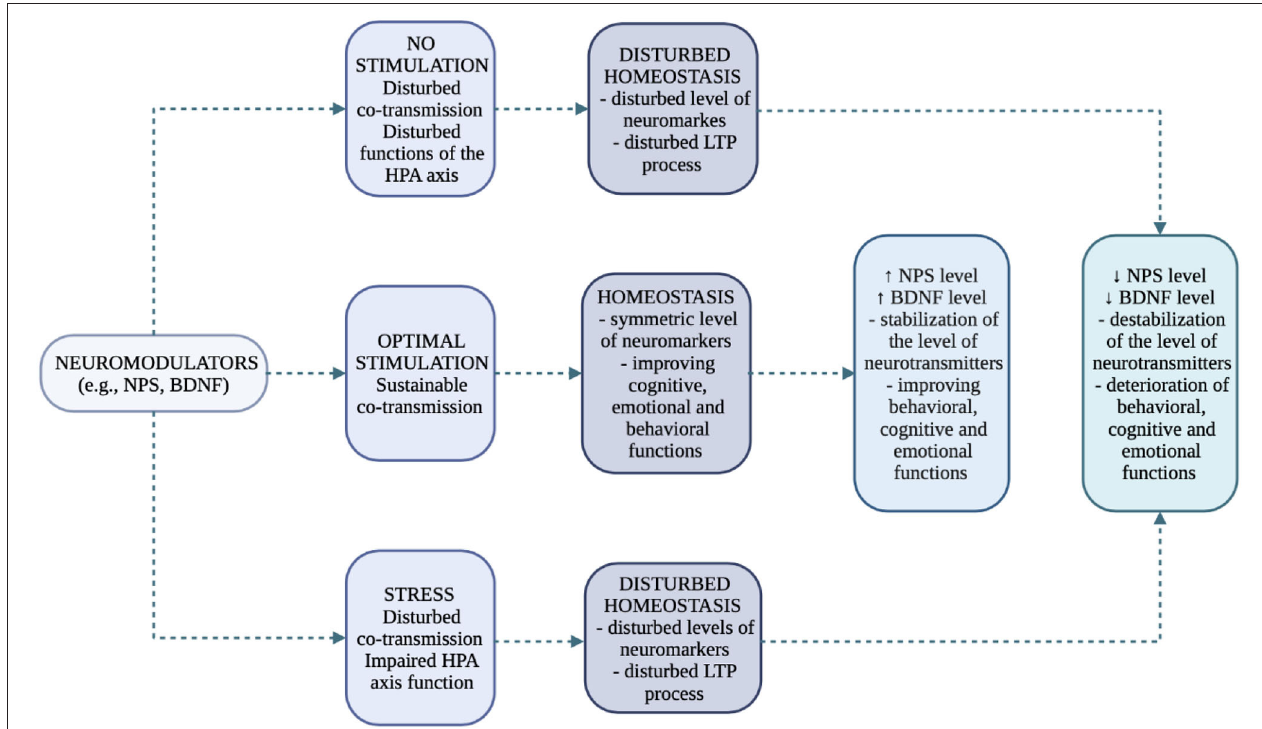
FIGURE 4 | Functions of neuromarkers and their effects in the process of neurogenesis (own work based on the literature) (19, 39, 41–44). The limbic system (cerebral cortex, subcortical structures including the amygdala nuclei, hippocampal bend) is involved in the process of perception of a stressful situation (externally and internally conditioned). A stressful situation has a two-stage course and is subject to primary verification by the amygdala and secondary verification by the hippocampus. The amygdala transmits single sensory signals (autonomic and endocrine responses), while the hippocampus transmits the processed and analyzed signals that are directed from the thalamus and areas of the cerebral cortex. The goal of a synchronized stress response system is to restore internal homeostasis. No Stimulation: decreased level of stimulation; Optimal Stimulation: appropriate regulation; Stress: increased level of stimulation; Disturbed Homeostsis: unbalanced homeostasis; both the deficiency and the excess of stimulation cause disturbed homeostasis in the